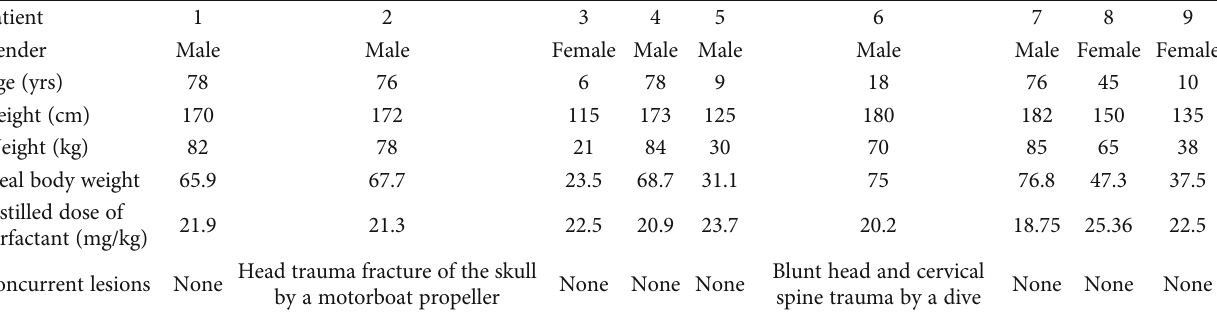
Table 1: Patients ’ characteristics and instilled dose.